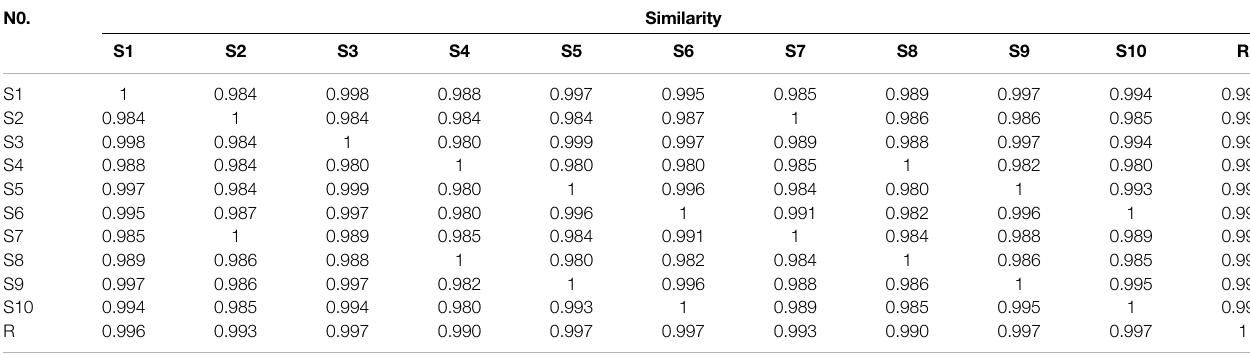
TABLE 1 | The results of similarities of the chromatograms from different batches of GDD. N0.